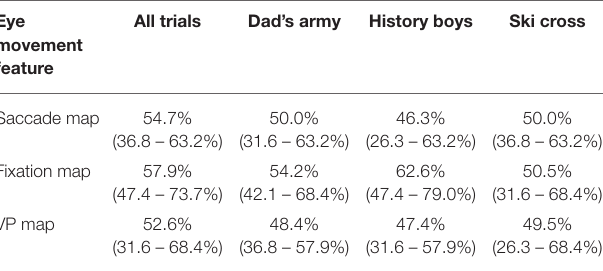
TABLE 3 | Accuracy of the naïve Bayes classifier for each of the maps. Eye